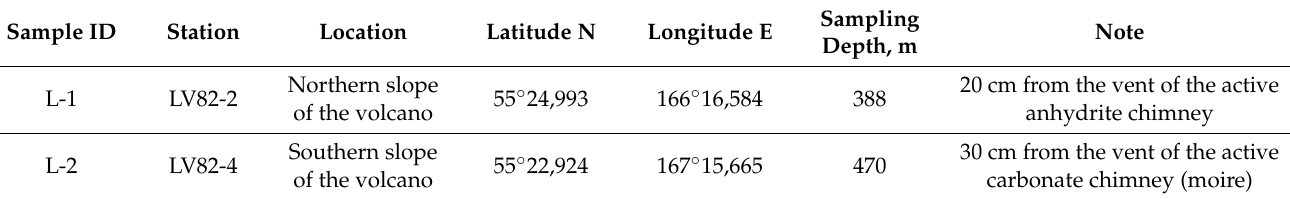
Figure 2. Hydrothermal vent edifices of the northern ( a , b ) and southern ( c , d ) tops of the Piip Volcano. Table 1. The biotope water samples from the Piip